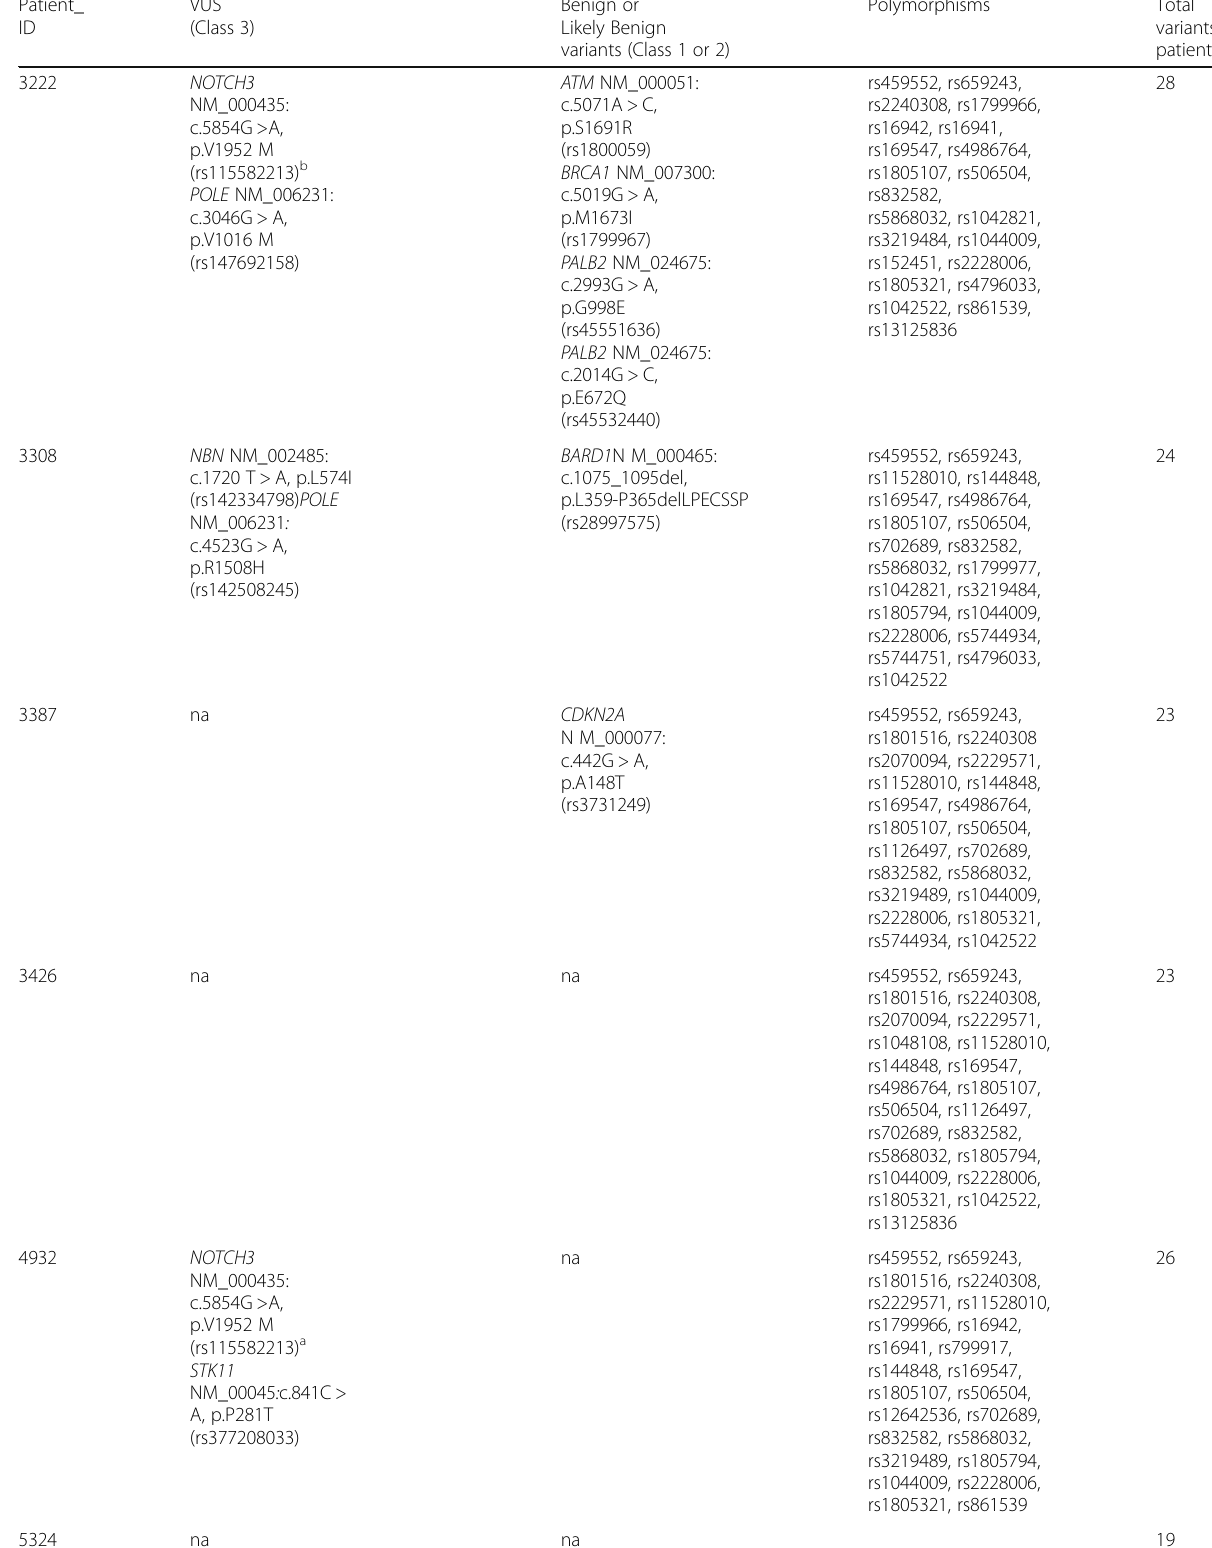
Table 2 Characterization of germline variants found among Norwegian familial CRC